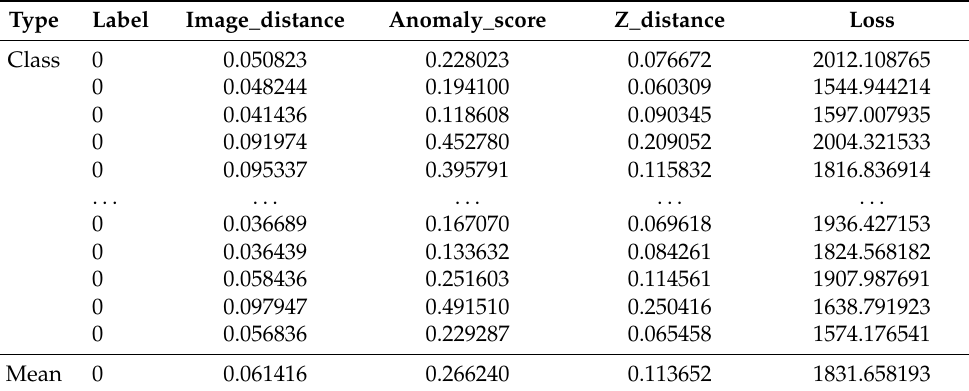
Table 2. Performance matrix of anomaly detection score for anomaly data.